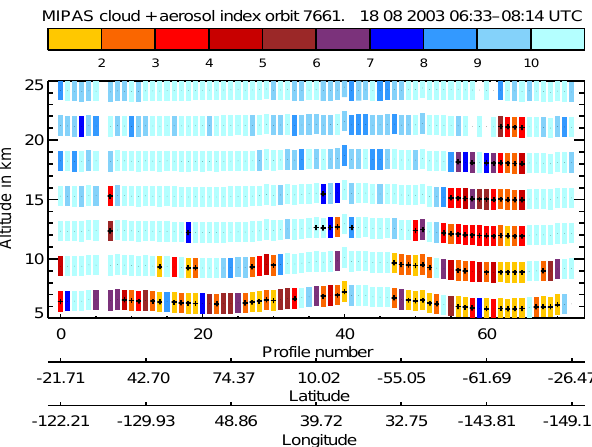
Figure A2. ACI profiles for MIPAS orbit 7661 measured on 18 Au- gust 2003. The black crossed denote cloudy regions identified by a fixed CI threshold of 2 below 10km and by the variable thresholds above 10km (Sembhi et al.,